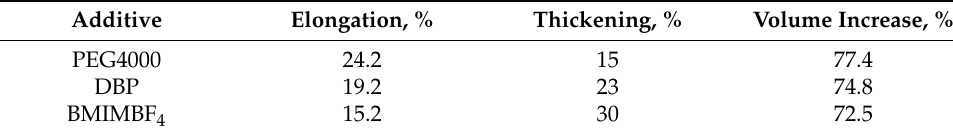
Figure 1. PVDF porous films washed from the pore-forming agent ( left ) and impregnated in BMIMBF4 ( right ). Table 3. PVDF film parameters changing during impregnation.